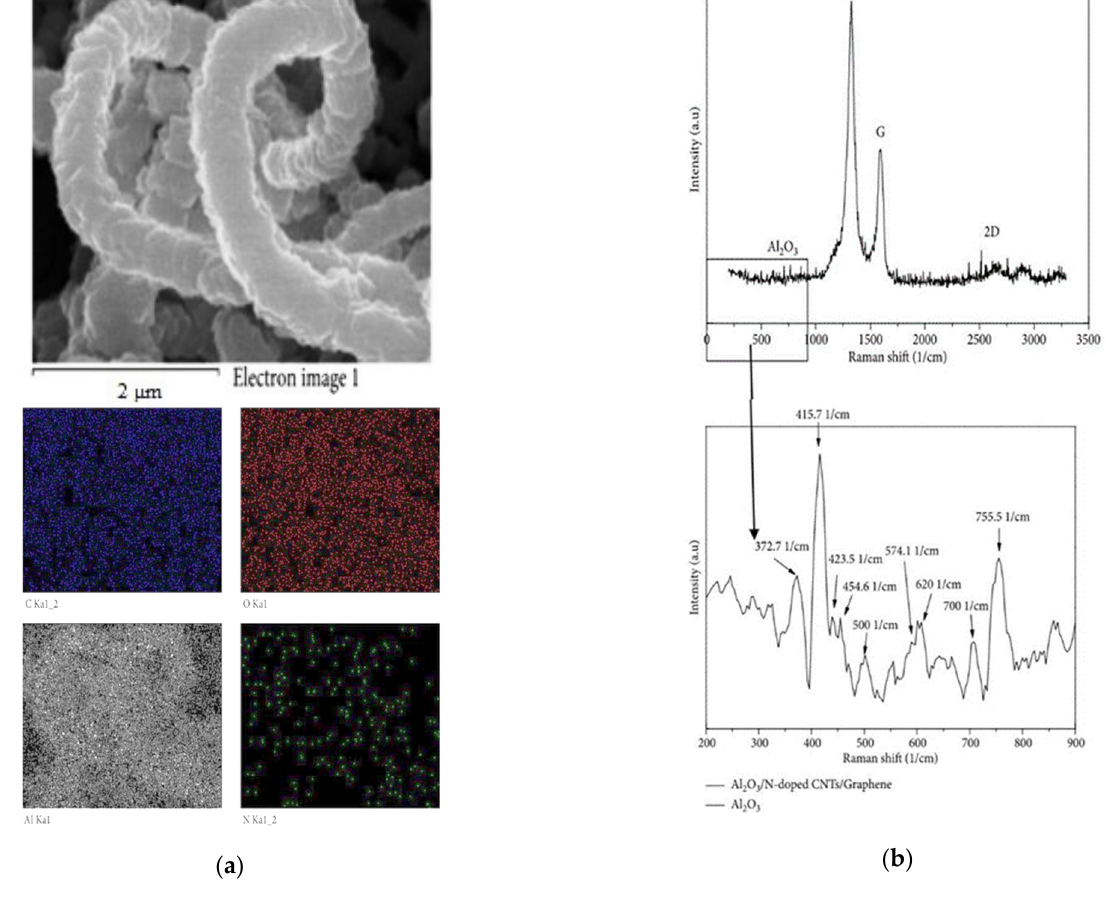
Figure 4. ( a ) Field emission scanning electron microscopy image and energy X-ray dispersive spectroscopy elemental mappings of C, O, Al, and N in aluminium oxide (Al 2 O 3 )/N-doped carbon nanotubes (CNTs)/graphene. ( b ) Raman spectroscopy of aluminium oxide (Al 2 O 3 )/N-doped carbon nanotubes (CNTs)/graphene [35].